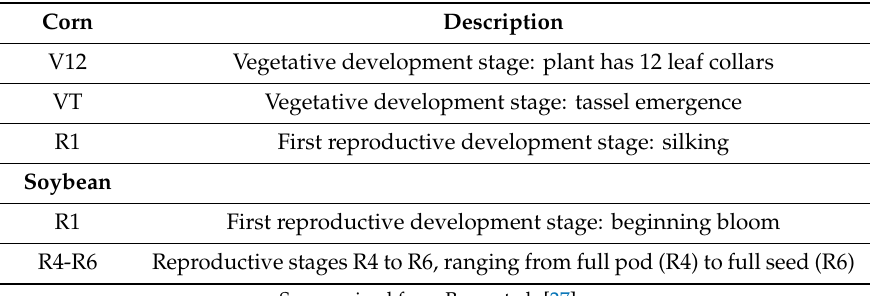
Table 7. Important development stages for corn and soybean. Corn